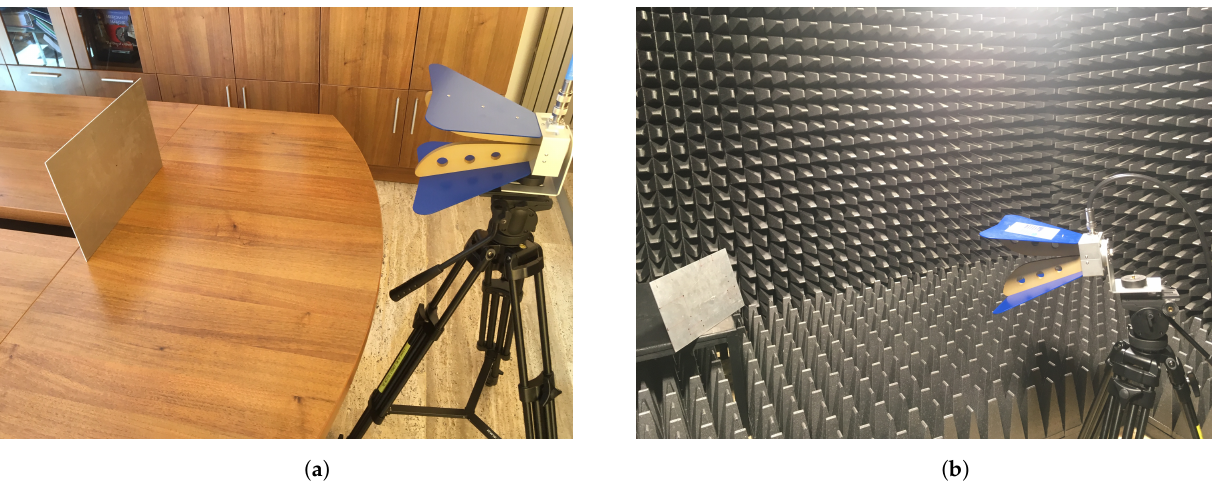
Figure 5. Measurement configuration in a real environment ( a ) and in an anechoic chamber (AC) ( b ). The S 11 parameter was measured for eight ranges equally spaced between 100 and 170 cm, all of them in the near-field zone (Figure 6).